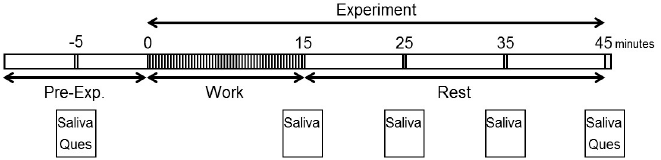
Figure 2. Experimental design. Saliva: saliva sampling, Ques: questionnaire.